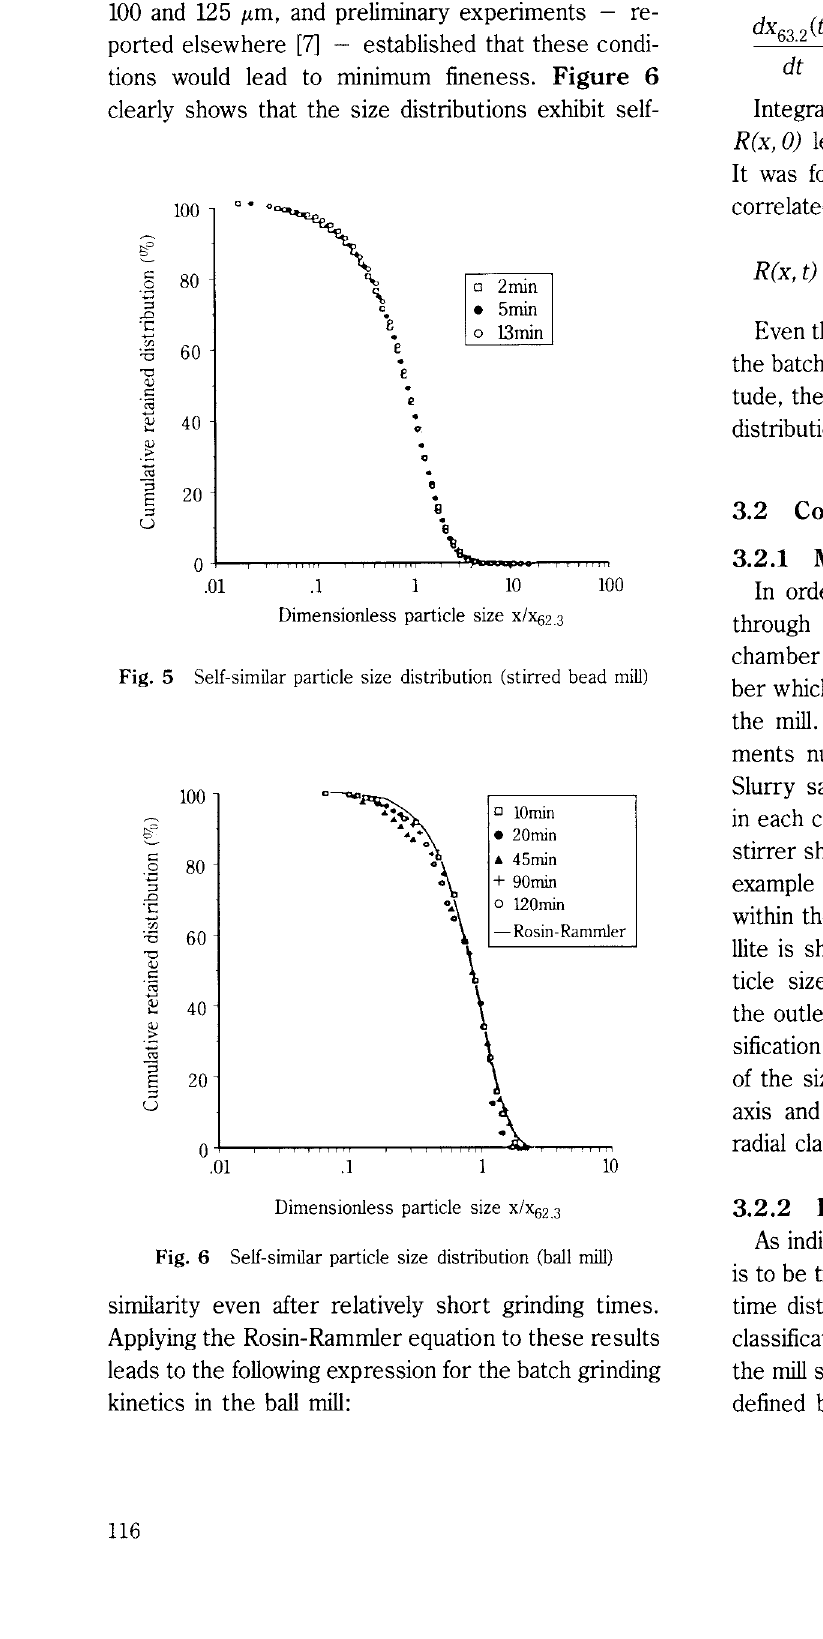
Fig. 6 Self-similar particle size distribution (ball mill) similarity even after relatively short grinding